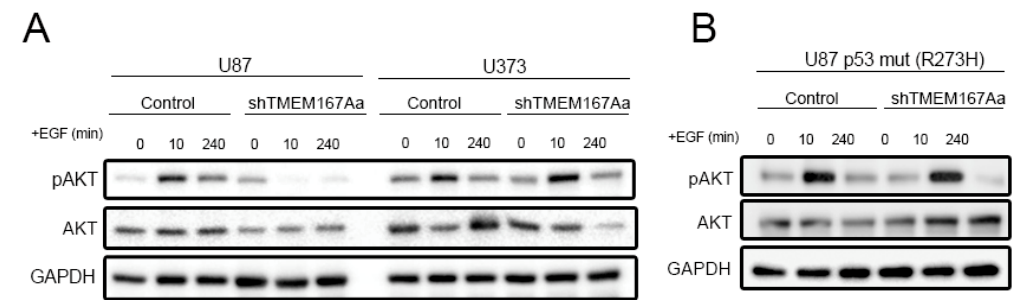
Figure 6. Overexpression of mutant p53 rescues the e ff ect of shTMEM167A. ( A , B ) Growth factor-starved U87 and U373 cells ( A ) and U87 Tp53 mut (R273H) cells; ( B ) expressing shControl (Control) or shTMEM167Aa was stimulated with 100 ng / mL of EGF for the indicated times. The amount of pSer473-AKT (pAKT) was tested by WB. GAPDH was used as loading control.